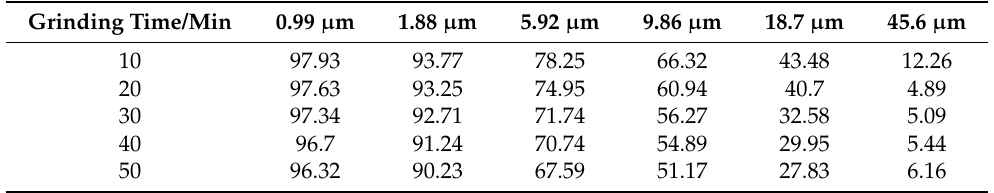
Table 3. Sieve residues of six representative sizes of LVTC powder/mass